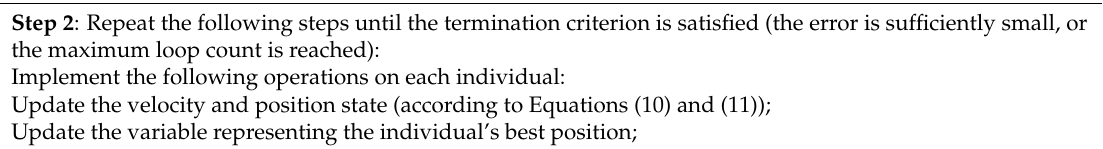
Table 3. Calculation flow of particle swarm optimization (PSO).